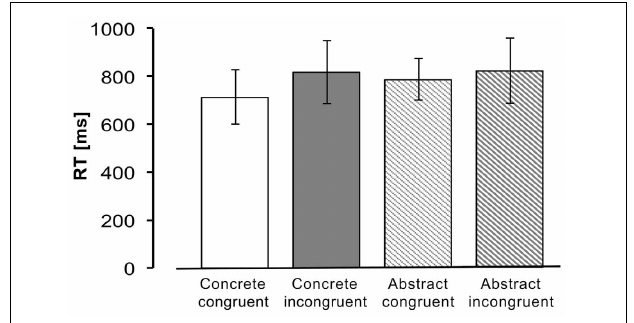
FIGURE 3 | Bar-plots of the reaction time data for the four different sentence types used in the EEG experiment.